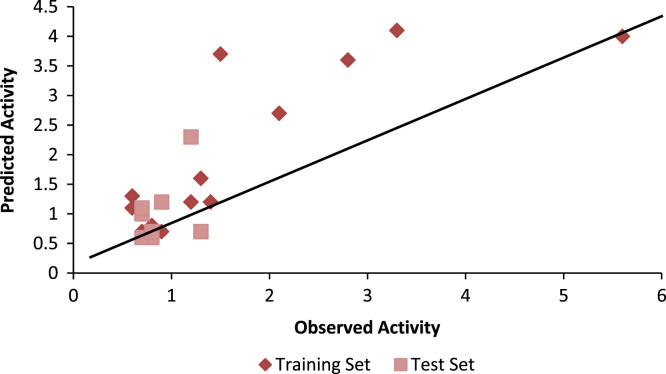
Figure Showing Correlation Plot for Selected GQSAR model having r2 0.88.